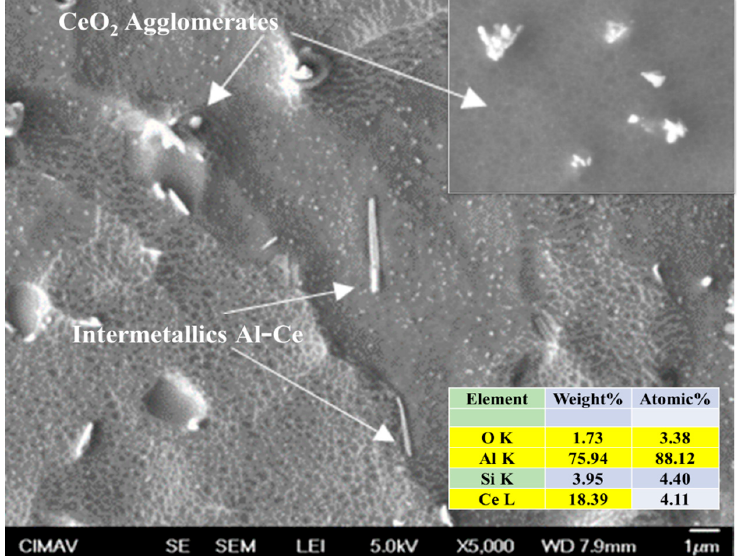
Figure 13. ( a ) SEM secondary electrons image of the Al/CeO 2 composite.